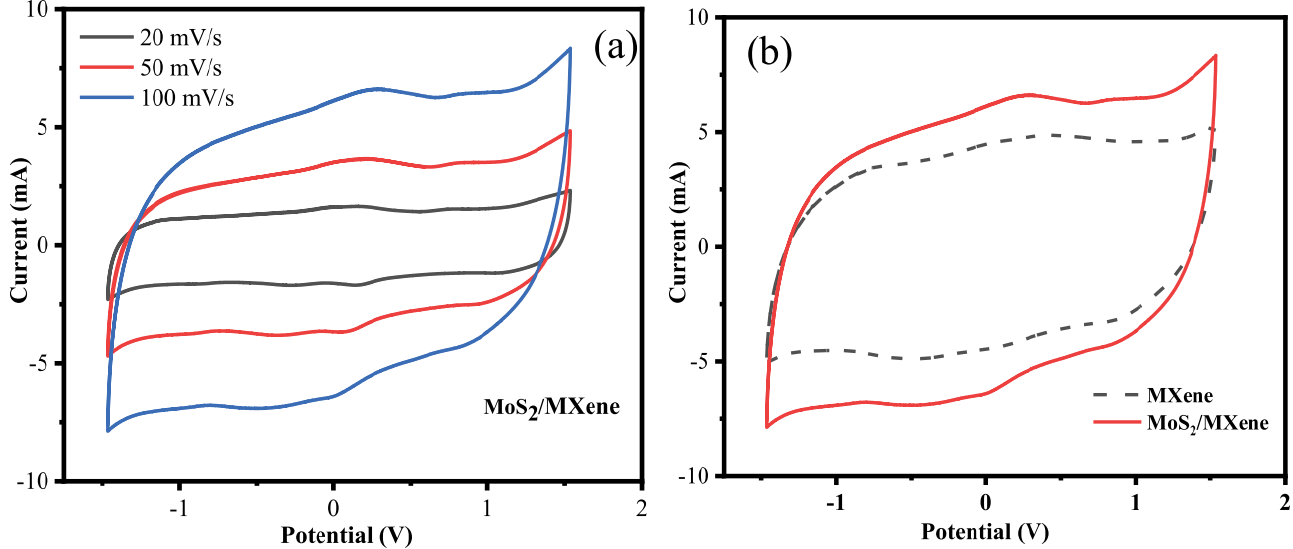
Figure 18. Cyclic voltammetry for MoS 2 /MXene from ref. [87]. Copyright 2020 Elsevier. ( a ) CV curve for MoS 2 /MXene electrode in various scan rates, ( b ) CV curve for MoS 2 /MXene and MXene electrodes in 100 mVs − 1 scan rates.